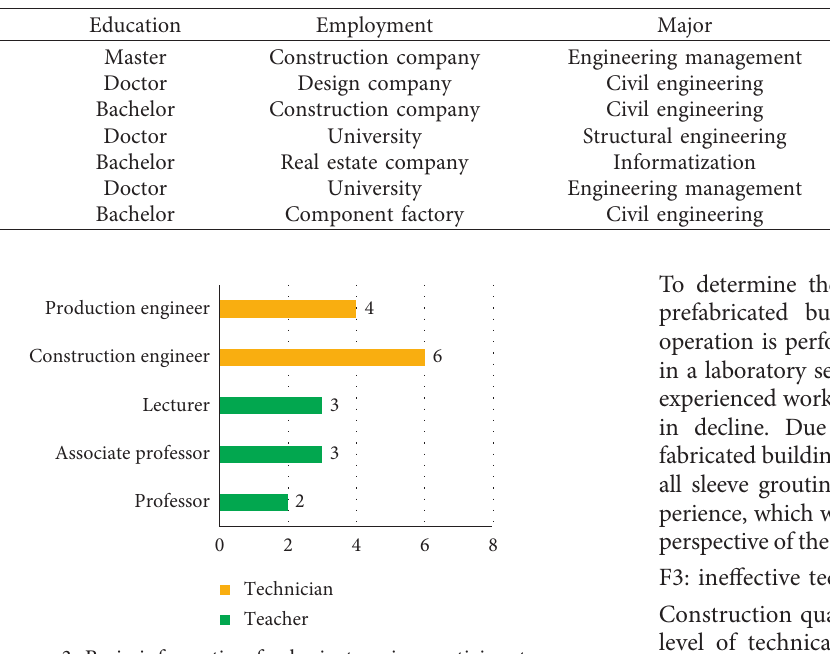
Table 1: Background of experts in the third round.